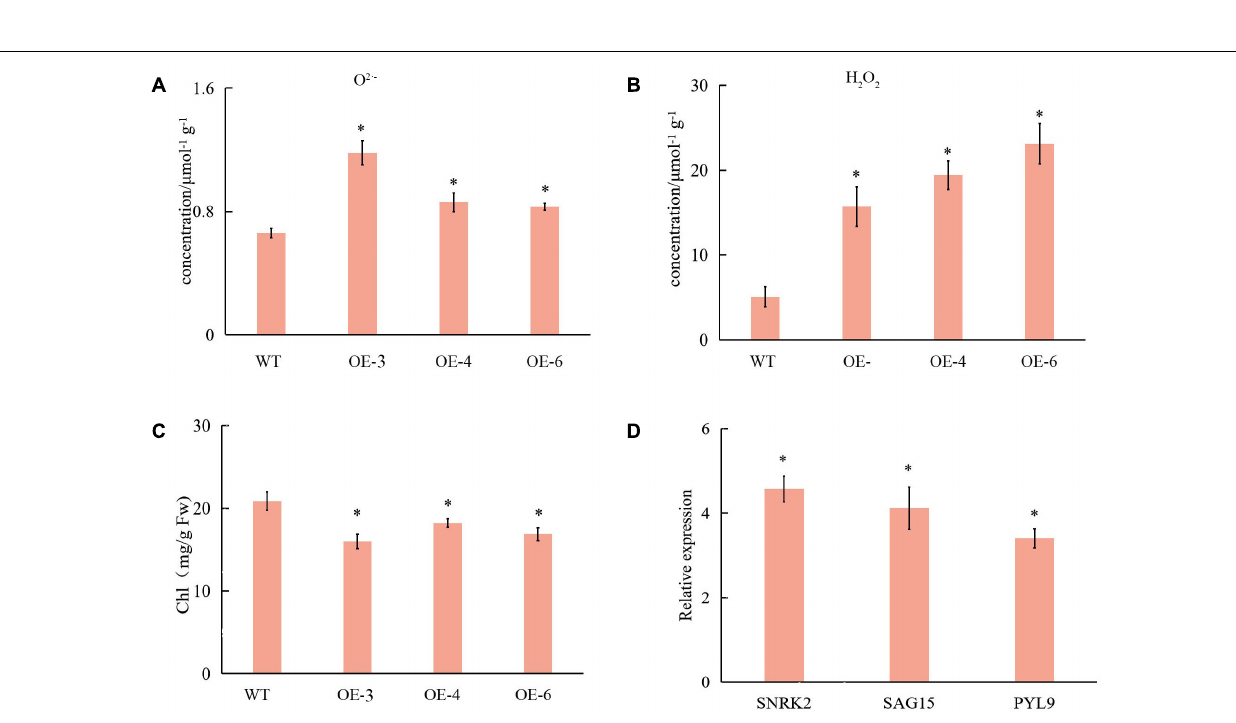
FIGURE 8 | Quantitative real-time PCR validation of differentially expressed genes. (A–C) , IAA response/signal-related genes; (D–F) ETH response/signal-related genes; (G–I) ABA response/signal-related genes; (J) ROS signal-related genes; (K) and (L) , Mg 2 + related genes. *Significant differences with P < 0.05 determined using a Duncan’s test compared with the control.